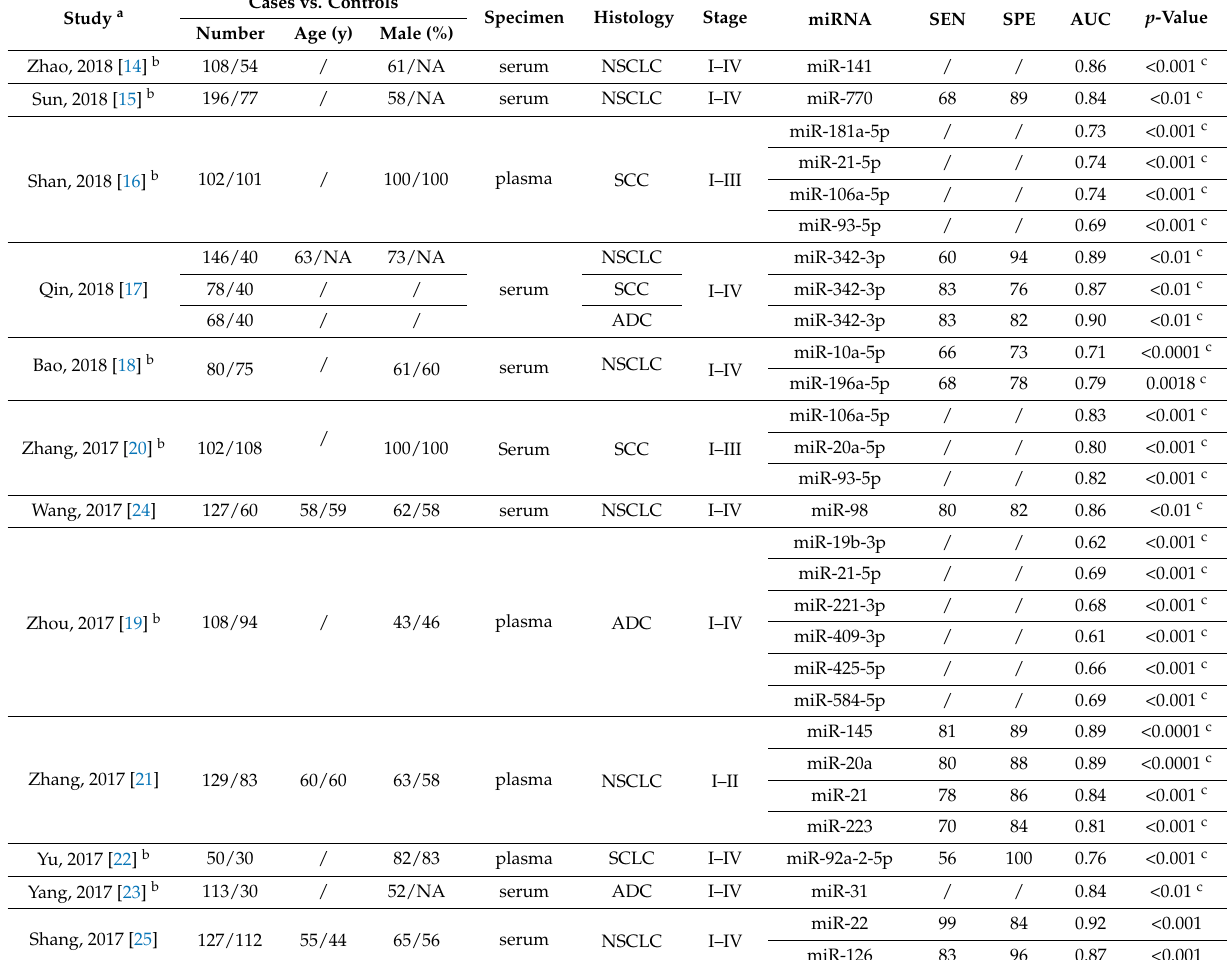
Table 1. Diagnostic performance of miRNA markers in lung cancer in East Asian